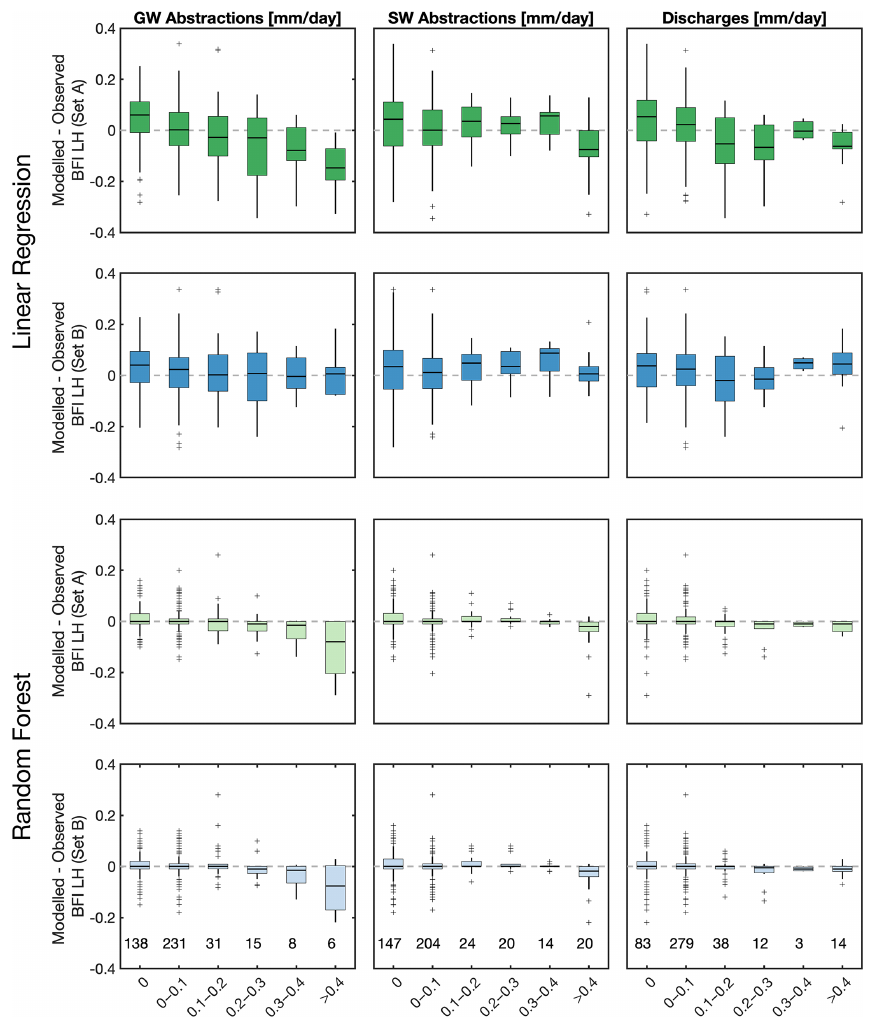
Figure A4. Comparison of observed and modelled BFI_ CEH for covariate Sets A and B, for LR and RF models and as a function of different human management categories. (Note this is the same as Fig. 8 but for